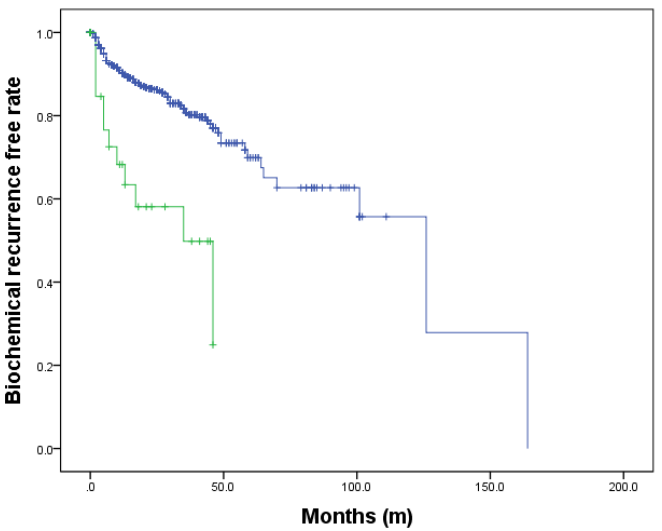
Figure 7. Biochemical recurrence free survival according to ARRDC4 variant.